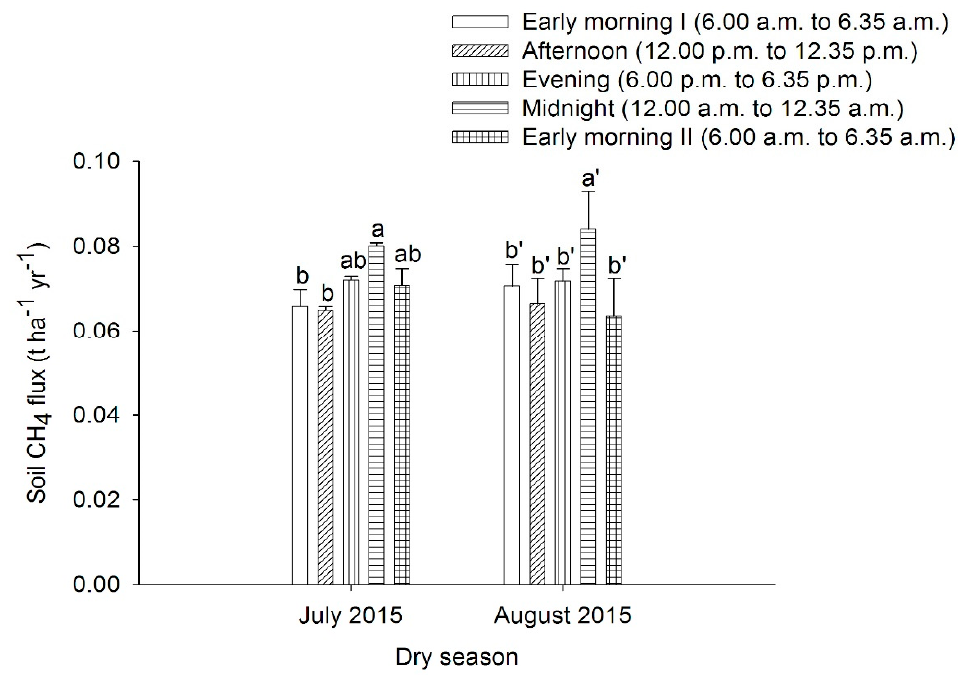
Figure 5. Soil CH 4 emissions (at different times of the day) from a tropical peatland cultivated with pineapples in the dry season (July and August 2015). Error bars represent standard error and soil mean fluxes with different letters and noted by prime are significantly different using Duncan’s new multiple range test (DNMRT) at p ≤ 0.05.